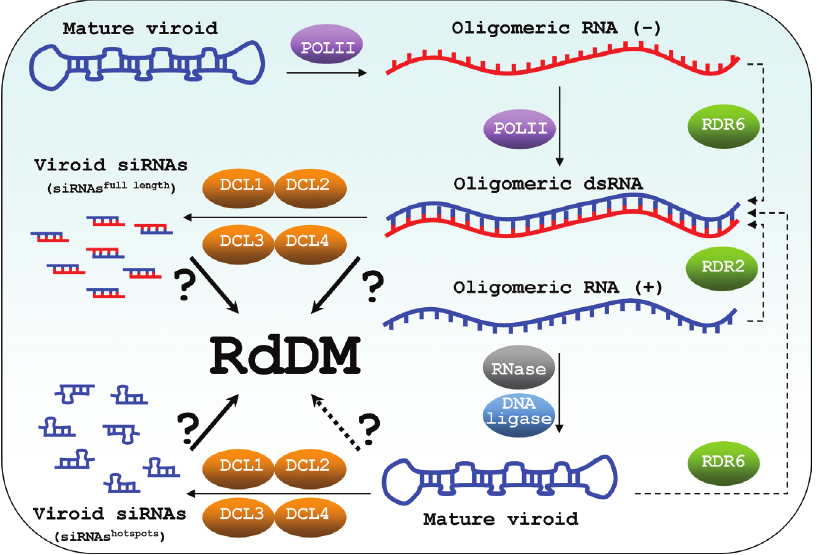
Figure 1 Life cycle of Pospiviroidae. Upon inoculation, mature Pospiviroidae RNA molecules enter the plant cell nucleus. During the asymmetric replication circle, POLII transcribes circular viroid RNA into oligomeric RNA of (-)-orientation. In the nucleoplasm, this RNA is transcribed into oligomeric (+) RNA, again by POLII. Subsequently to its transport into the nucleolus, a type III-like RNase and a DNA ligase are recruited to assemble the mature viroid molecule. Oligomeric (+) and (-) replication intermediates may form dsRNA molecules. Alterna- tively, dsRNA molecules may be produced by RDR6-mediated transcription of mature viroid RNA and/or of oligomeric (-) in the nucleoplasm. In addition, it cannot be excluded that, in the nucleolus, dsRNA is synthesized by RDR2 transcription of oligomeric (+) RNA. All four DCLs produce vd-sRNAs. However, it is not clear whether only dsRNAs or, due to the high capacity of viroid RNA to form intermolecular second- ary structures, also single-stranded viroid RNA is processed. If dsRNA is processed, fully complementary 21–24-nt siRNAs are produced that ideally cover the full length of the viroid (siRNAs full length ). Both polarities of vd-sRNAs could be loaded onto AGOs. If ssRNA viroid is processed, siRNAs will most probably be produced only from hotspot regions displaying secondary structures that are recognized by DCLs (siRNAs hotspots ). They are not perfect duplexes and may be only of (+) polarity. Whether dsRNAs, siRNAs full length or siRNAs hotspots guide the RdDM machinery to cognate DNA is not